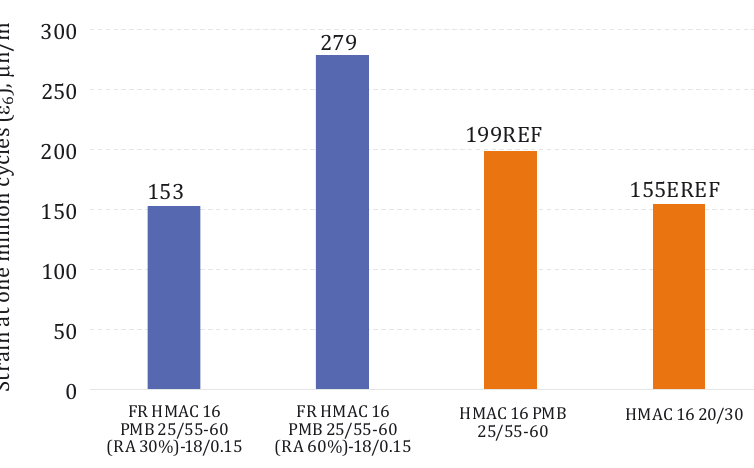
Figure 9. Stiffness modulus for the HMAC